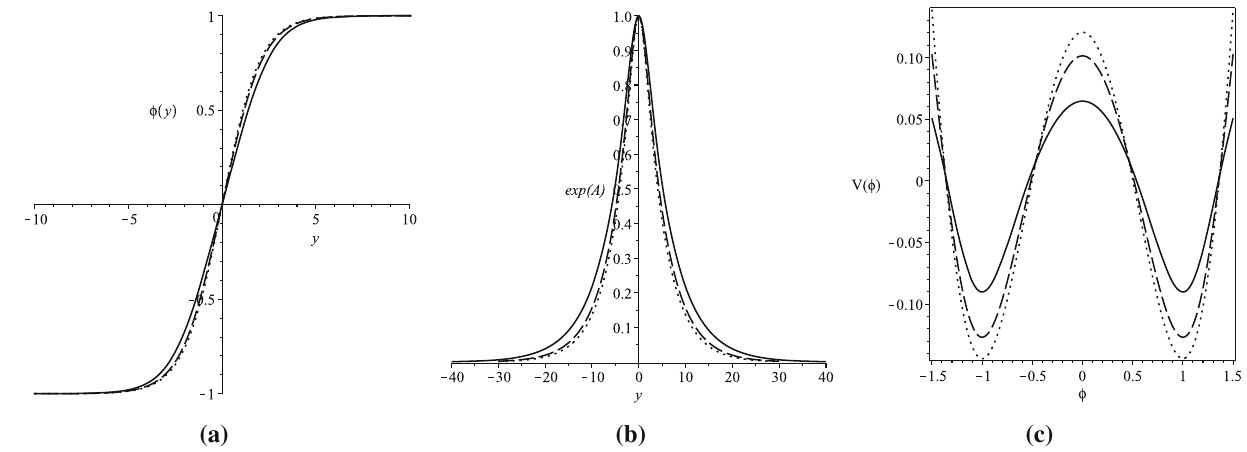
Fig. 1 The profile of a the background scalar field φ( y ) , b the warp factor e A ( y ) and c the scalar field potential V (φ) for a = 1 (solid line), a =2 (dashed line), a = 5 (dotted